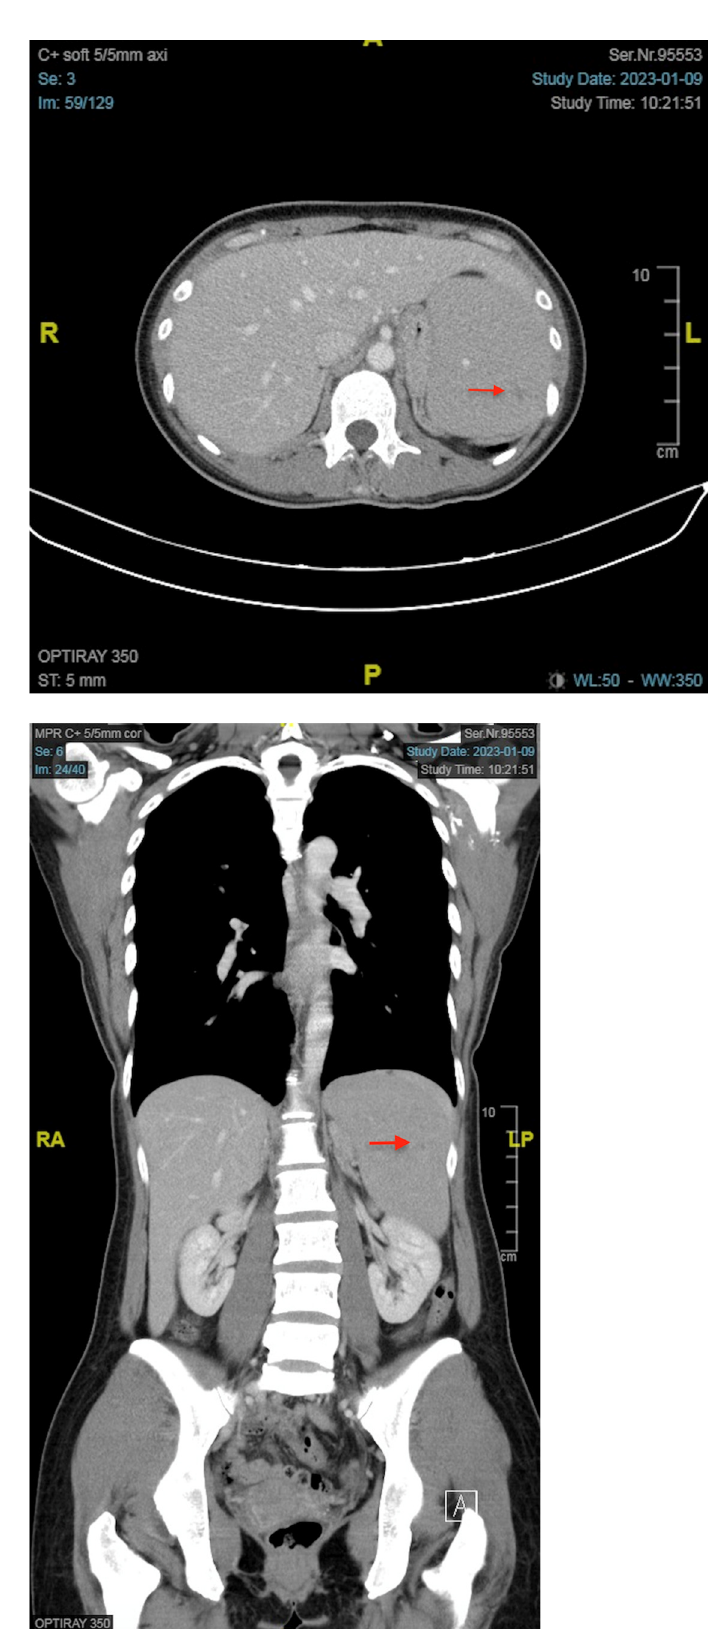
Figure 2. Contrast-enhanced abdominal computed tomography images of the patient. Both the axial and coronal views demonstrated splenomegaly with a tiny splenic infarct (arrow).